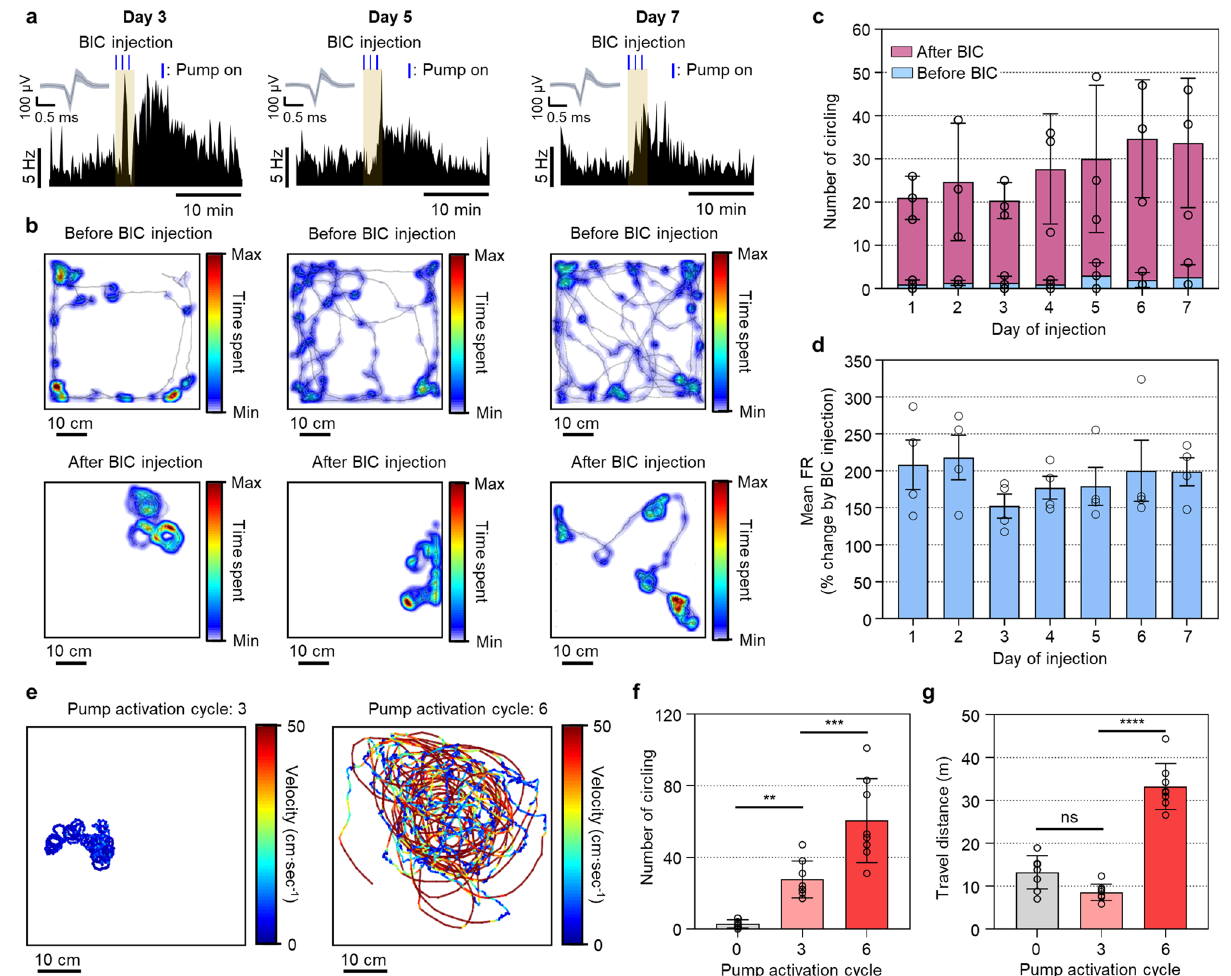
Fig. 4 | Controllable, chronic drug delivery, and consequent neural and beha- vioralchanges.a FiringratesofarepresentativeSNneuroninaccordancewithBIC injection onday3,day 5, andday 7. Insetshowsarepresentative neural signal. The bluelineabovetheheatmapindicatesthetimeatthepumpon(3cycles;5sonand 55s off over a 60s period). b Behavior heatmap of a representative mouse in accordance with BIC injection on day 3, day 5, day 7 (5min period). c Number of circlingbeforeandafterBICinjectiondailyfor7days(5minperiod; n =3where n is the number of mice). d Increase in the mean fi ring rates after the injection of BIC daily for 7 days ( n =4 where n is the number of neurons). e Representative trajec- torieswithvelocityheatmapafterBICinjectionbyactivatingthepumpwith3cycles